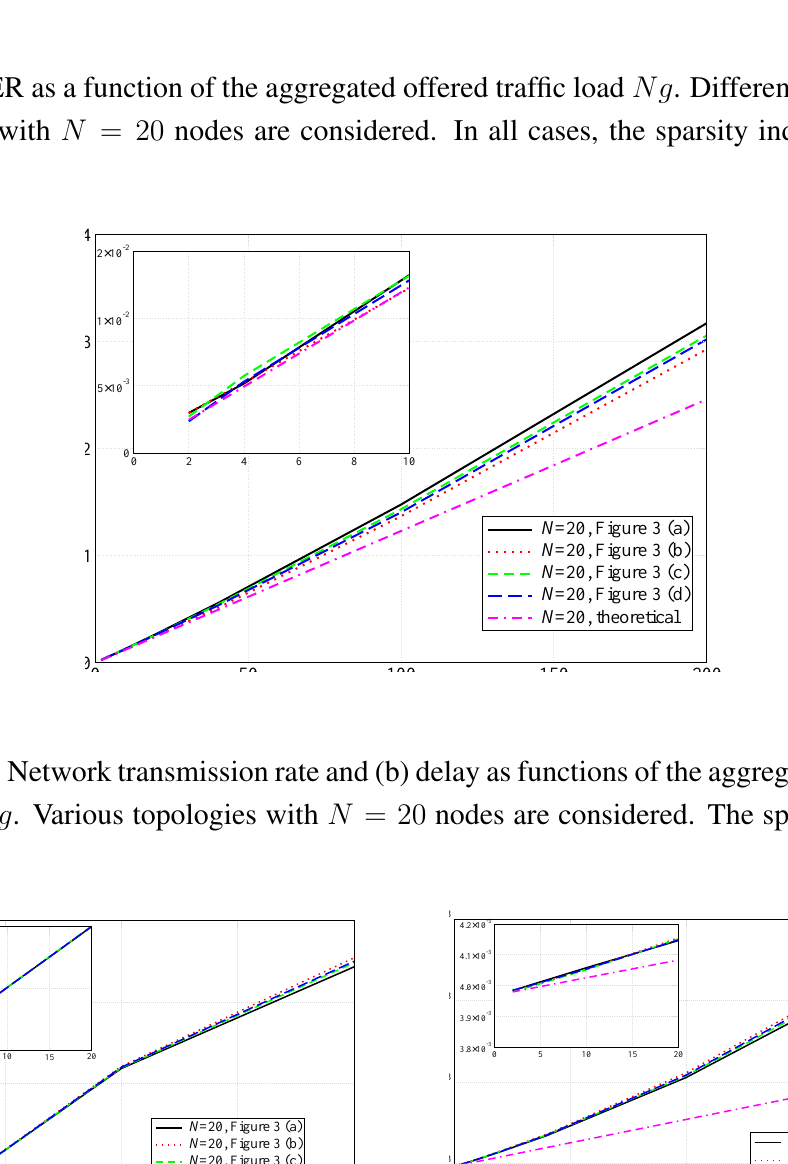
N =20, Figure 3 (a) N =20, Figure 3 (b) N =20, Figure 3 (c) N =20, Figure 3 (d)